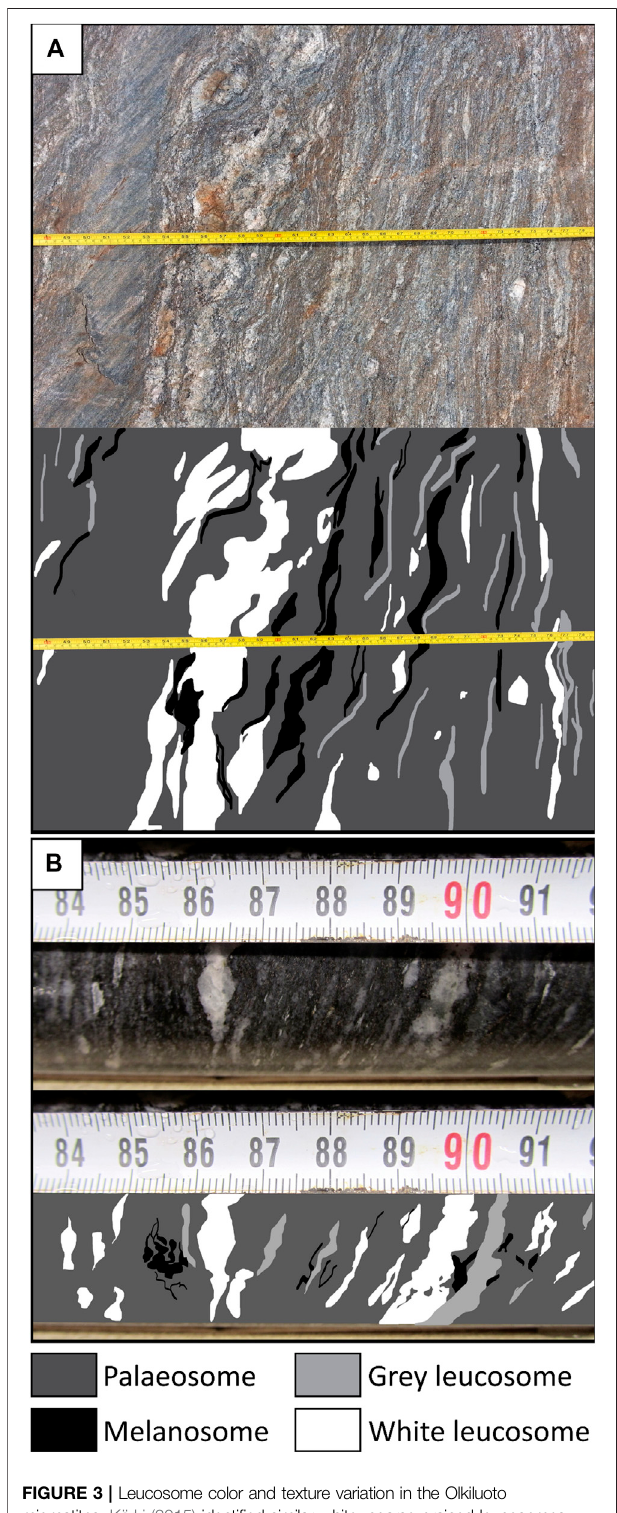
FIGURE 3 | Leucosome color and texture variation in the Olkiluoto migmatites. Kärki (2015) identi fi ed similar white, coarse-grained leucosomes cross-cutting thin gray leucosomes on another outcrop in Olkiluoto, indicating that the two sets crystallized at different times. (A) Thin gray leucosomes andwhitepegmatiticleucosomes. Picture from a fl at outcrop,taken directlyfrom above. (B) Thin gray leucosomes and pegmatitic white leucosomes from a drill- core